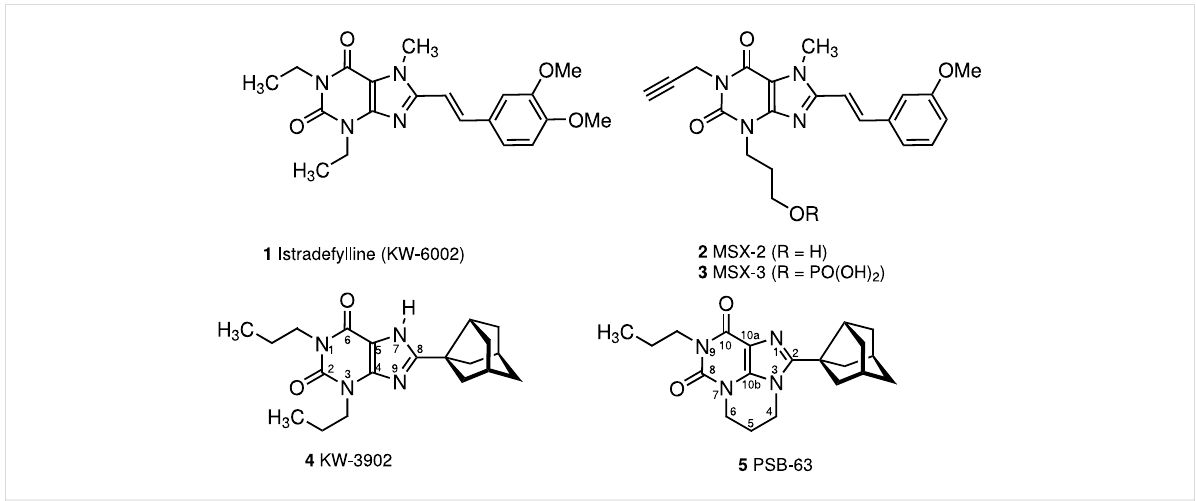
Figure 1: Potent, selective adenosine A 1 and A 2A receptor antagonists with xanthine